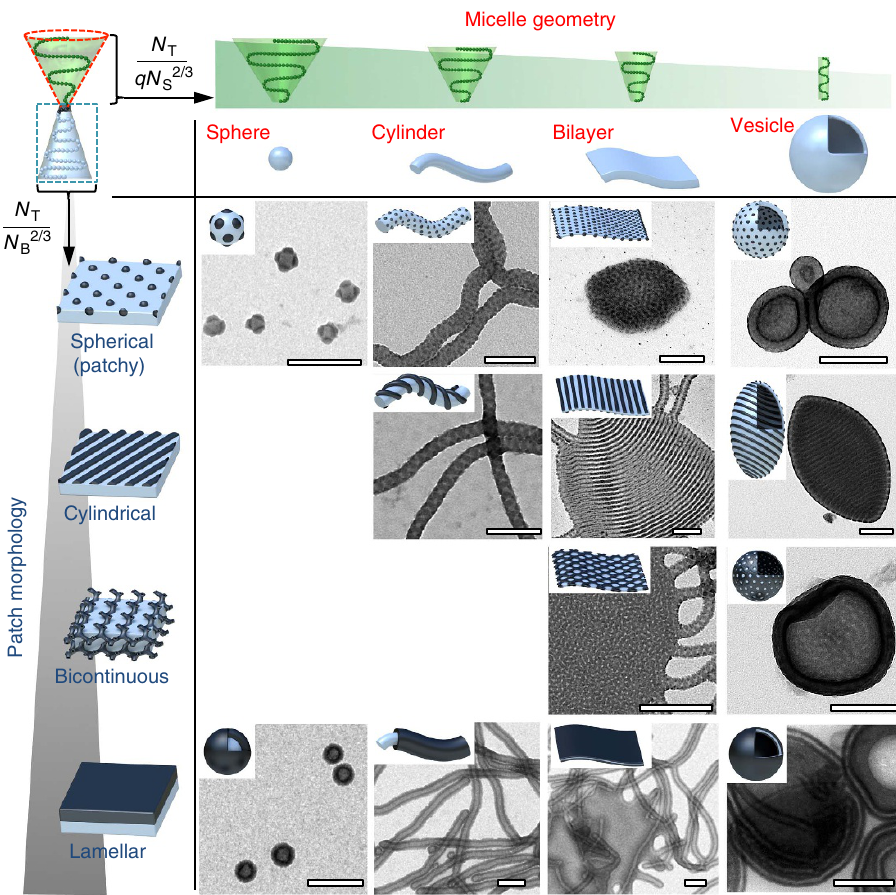
Figure 6 | Experimental combinatorial table sub-classifying micelle geometry by patch morphologies. Sphere-on-spheres, spheres-on-cylinders, spheres-on-bilayer sheets and vesicles; cylinders-on-cylinders (double-helix patch), cylinders-on-bilayer sheets and vesicles; sheets and vesicles with bicontinuous membrane morphology; core–shell micelles, core-shell cylinders, lamellar sheets and vesicles. Solvent composition for each sample is given in Supplementary Table 4. Scale bars,